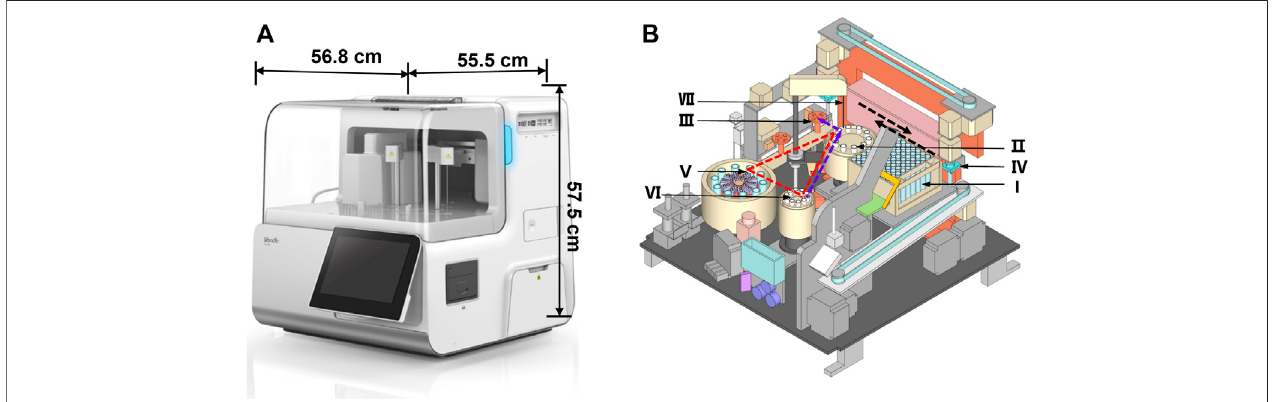
FIGURE 1 | Fully automated miniaturized analyzer (A) and the front view of the interior structure (B) . The number Ι - Ⅶ represented the tube storage device ( Ι ), rotational incubation device ( Ⅱ ), magnetic separation device ( Ⅲ ), grab device ( Ⅳ ), reagent storage device ( Ⅴ ), sample storage device ( Ⅵ ), and sample/reagent collection device ( Ⅶ ), respectively. The black dotted arrow represented the direction of the device Ⅳ ; the red dotted triangle represented the layout of the devices Ⅱ , Ⅴ , and Ⅵ ; the purple dotted arrow represented the movement track of the